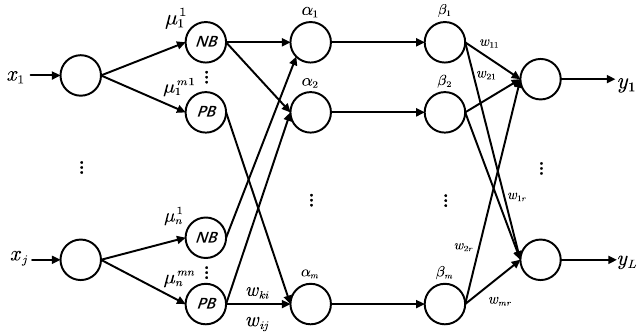
Figure 9. Diagram of Mamdani fuzzy neural network